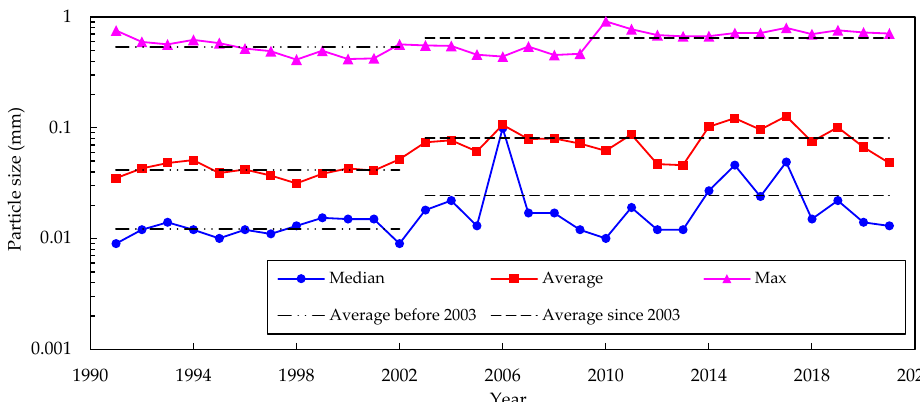
Figure 5. Annual change in characteristic particle size of the suspended load at Shashi station.